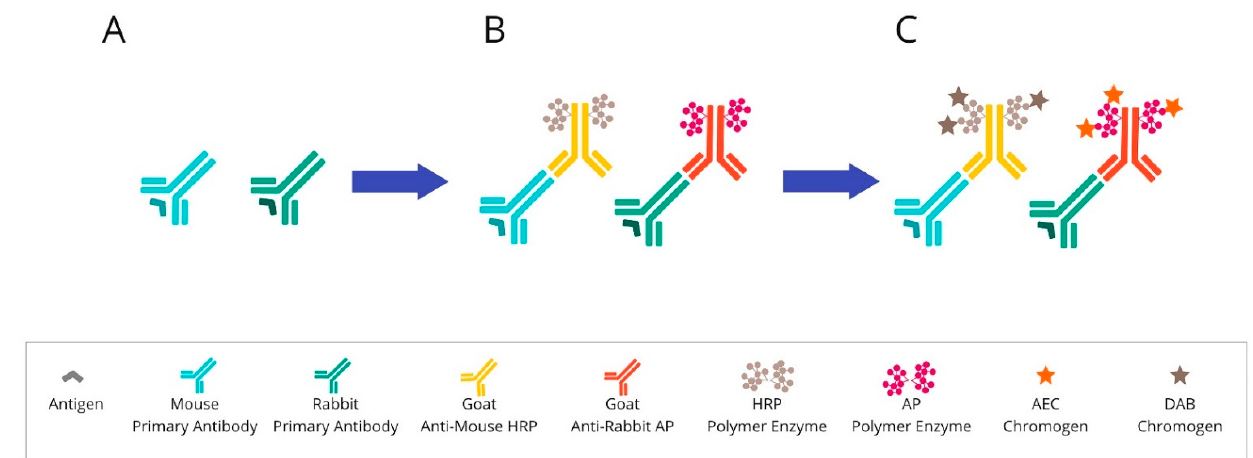
Figure 2. Overview of chromogenic-based mIHC: ( A ) After primary antibody incubation, ( B ) sec- ondary antibodies labelled with polymer enzymes are conjugated. ( C ) The HRP or AP are reacted with an appropriate substrate bound to a chromogenic dye, such as DAB or AEC, leading to the precipitation of insoluble, coloured products. Abbreviations: HRP—horseradish peroxidase; AP— alkaline phosphatase; DAB—3,3 ′ -diaminobenzidine; AEC—3-Amino-9-ethylcarbazole.